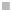
a. Children’s physical fitness (Léger test: A, B; Agility shuttle test: C, D; Long jump test: E, F) reported as a function of BMI category and age class. Girls: A, C, E; Boys: B, D, F. Underweight, ■; normal weight, ■; overweight, ■; and obese, ■. All values are means ± SE. *Significantly different relative to scores for normal weight children (p<0.05). b. Children’s physical fitness (frontal throw test: G, H; Sit & Reach test: I, J; standing balance test: K, L) reported as a function of BMI category and age class. Girls: G, I, K; Boys: H, J, L. Underweight, ■; normal weight, ■; overweight, ■; and obese, ■. All values are means ± SE. *Significantly different relative to scores for normal weight children (p<0.05).